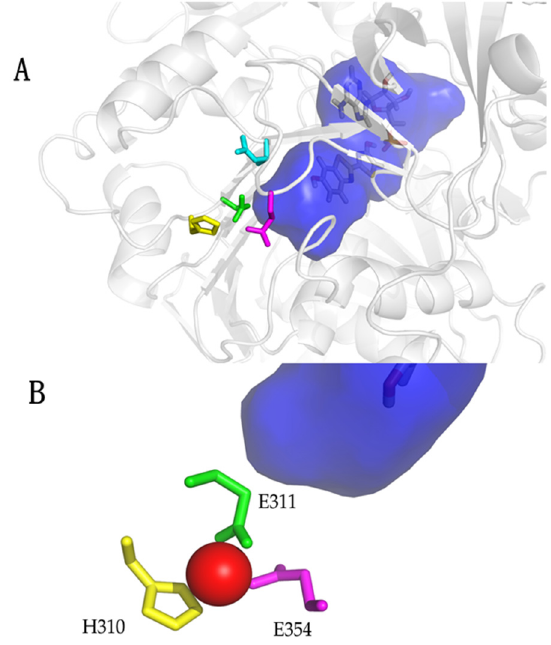
Figure 4. Structure of the metal-binding site in Amydetes viviani firefly luciferase: ( A ) Zoom showing the metal-binding site residues (yellow: H310; green: E311; magenta: E354) and oxyluciferin phenolate binding site (deep blue); ( B ) Metal-binding site showing zinc in red, being coordinated by the side chains of H310, E311 and E354. Reprinted from ref. [31].